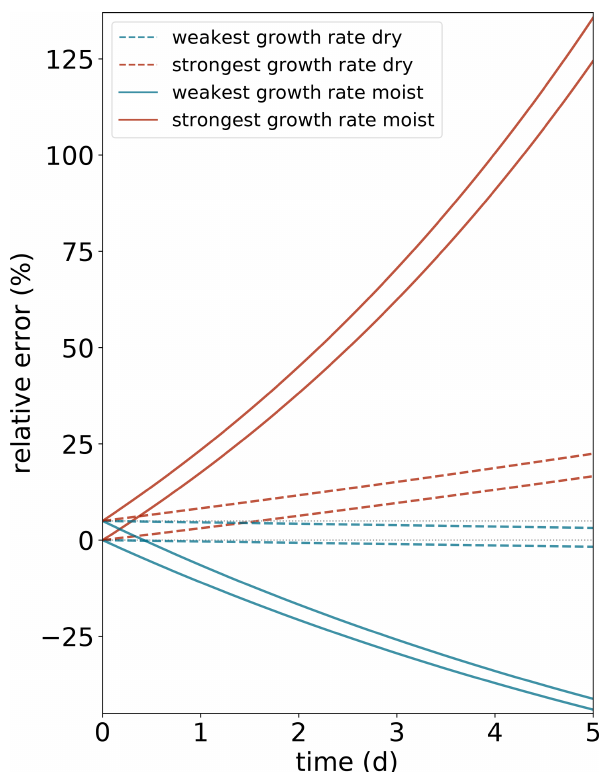
Figure 9. Evolution of error for the weakest (blue) and strongest (red) maximum growth rates from Fig. 6 (dashed, dry) and Fig. 10 (solid, moist) starting with initial relative errors of 0% and 5% (grey dotted horizontal